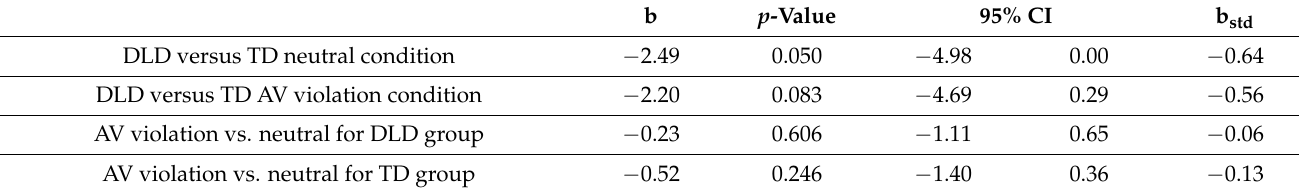
Table 4. Accuracy model simple effects for the group-by-condition